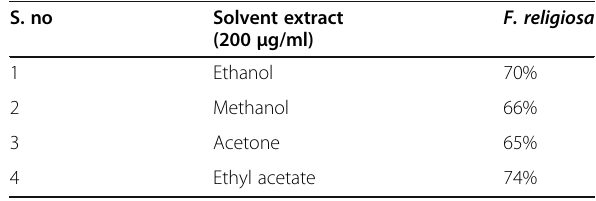
Table 4 % Cell viability of lymphocytes against F. religiosa